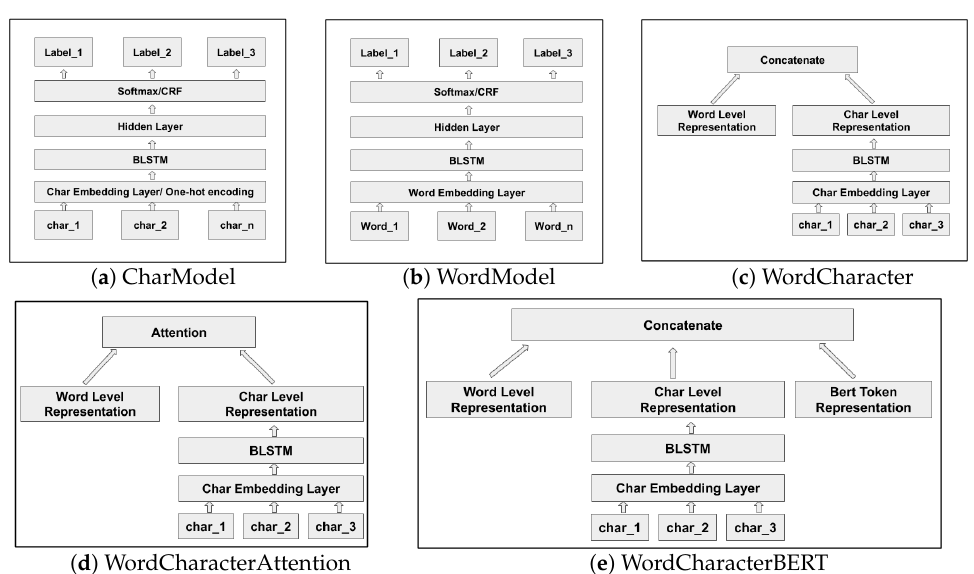
Figure 1. Architectures of the word, character and BERT level representation